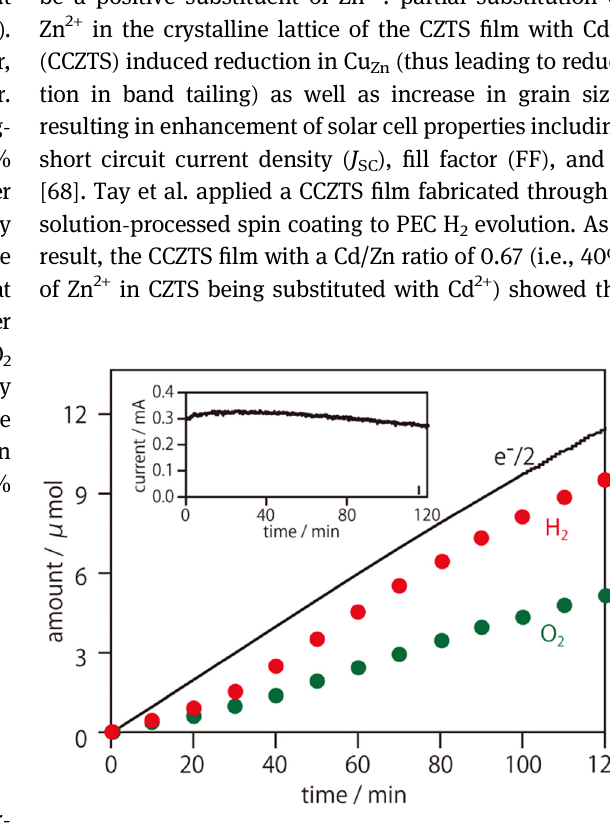
Figure 11: Time course curves of H 2 and O 2 evolution over the Pt/ In 2 S 3 /CdS/CZTS – BiVO 4 two - electrode cell under simulated sunlight ( AM 1.5G ) radiation. The solid line denotes the time course curve of half of the electrons passing through the outer circuit ( e − /2 ) . The inset shows the corresponding net current – time curve. Reprinted with permission from ref. [ 76 ] . ©2015 American Chemical